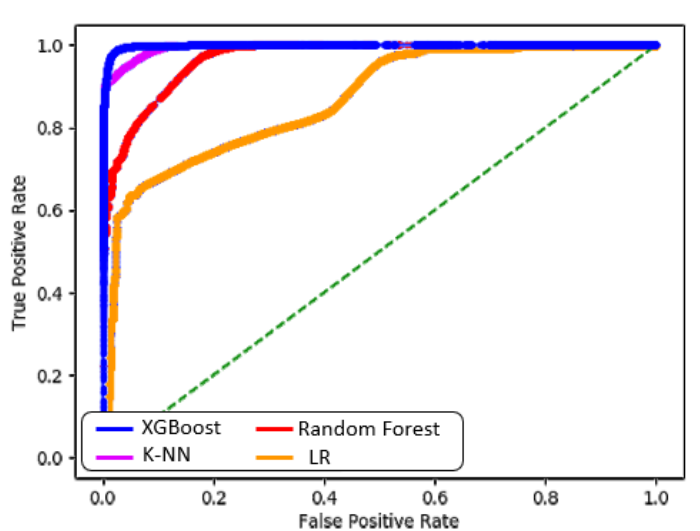
Figure 11. Comparison of all ML algorithms’ results.